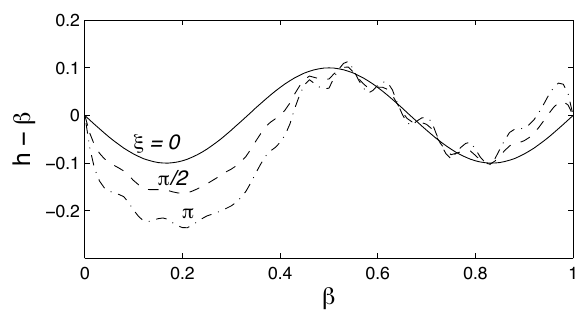
Fig. 14. Vertical structure of the isopycnal displacement h − β as a function of β at three values of ξ indicated next to each curve. The solution is 2 π periodic in ξ